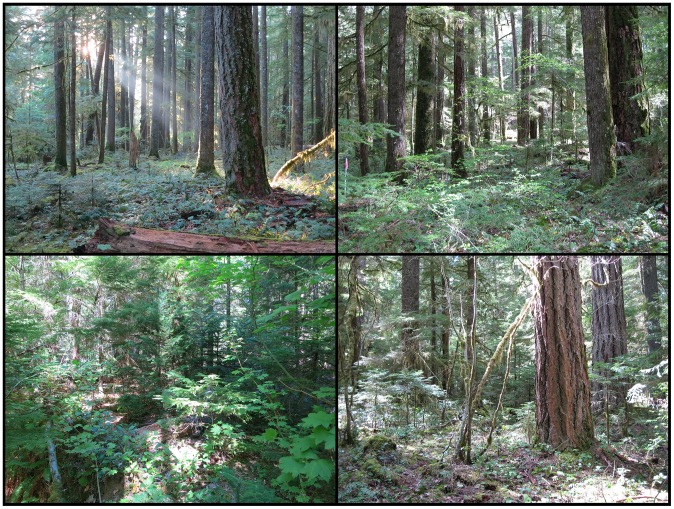
Structure and composition of the Wind River Forest Dynamics Plot (WFDP).Four images from different parts of the WFDP illustrate defining characteristics of the ecosystem. The forest is composed of an overstory of large-diameter trees with abundant but heterogeneous woody low shrub and herbaceous layers. Vegetation communities include Tsuga heterophylla/Mahonia nervosa (upper left image, August 19, 2012), and Tsuga heterophylla/Mahonia nervosa/Gaultheria shallon (upper right image, May 8, 2010). Regeneration by the shade-tolerant Tsuga heterophylla can be locally dense (lower right image, August 31, 2012). The most abundant species by stems, Acer circinatum, creates a seasonal sub-canopy layer (lower left image, May 8, 2010). All photos by J. A. Lutz.